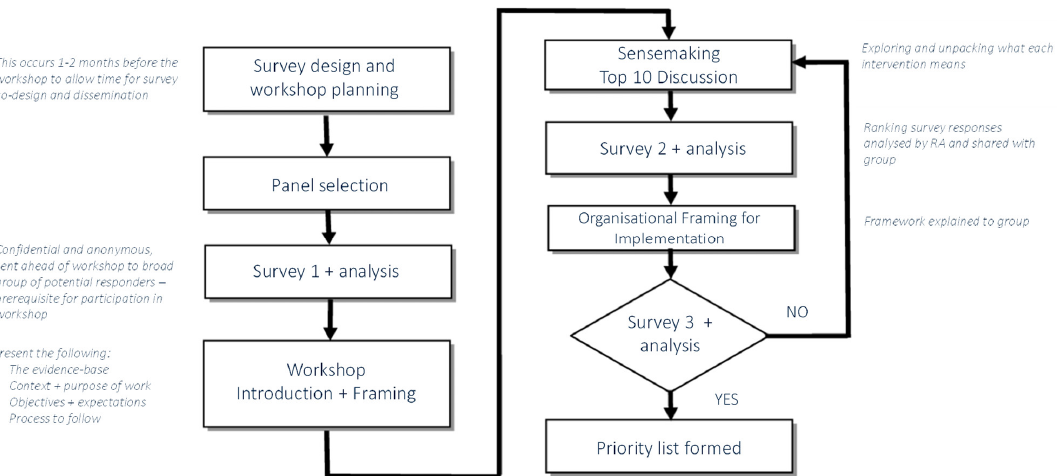
Figure 2. Workshop Process Map with embedded round 2 and 3 Delphi surveys and Nominal Group Technique.